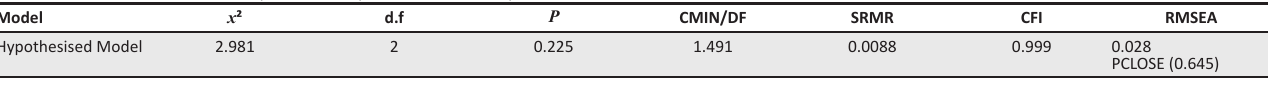
TABLE 3: Fit indices of Confirmatory Factor Analysis model for entrepreneurial actions. Model